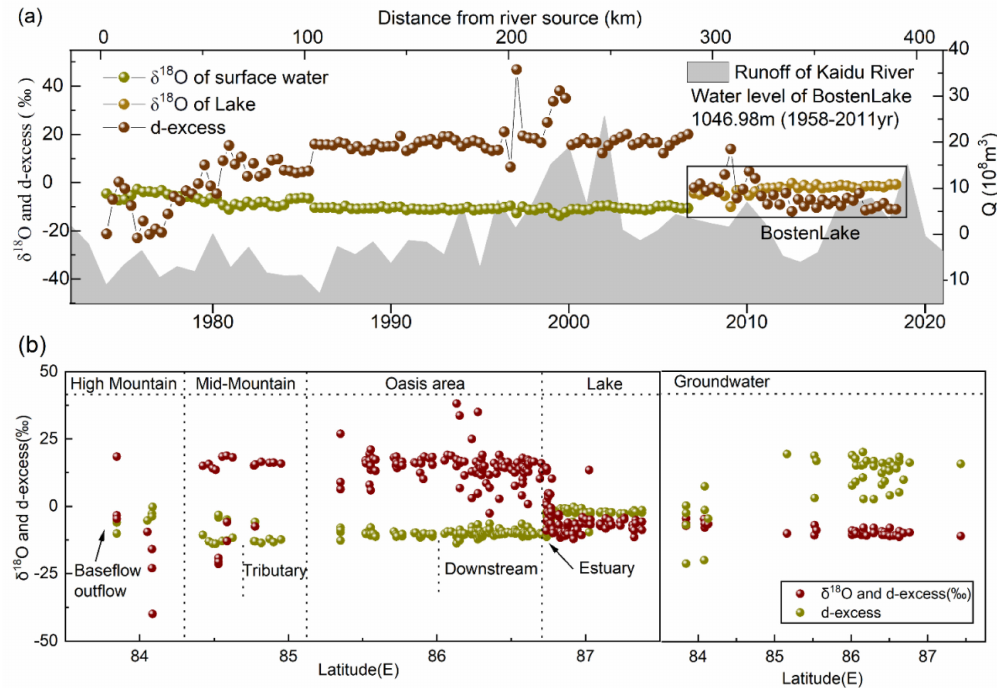
Figure 3. ( a ) δ 18 O (circles, ‰) and d-excess (triangles, ‰) fluctuations at sample sites vs. distance from river source (left and upper axis) and time series of discharge (solid line, 10 8 m 3 ) of the Kaidu River. Yellow circles denote lake isotope measurements during the ice-free period. ( b ) Spatial variations in δ 18 O of river water and